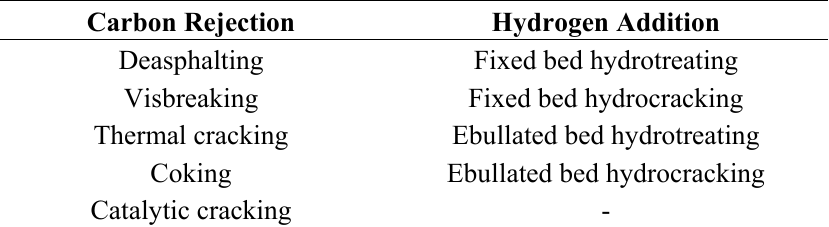
Table 1. Classification of technologies for upgrading heavy oil